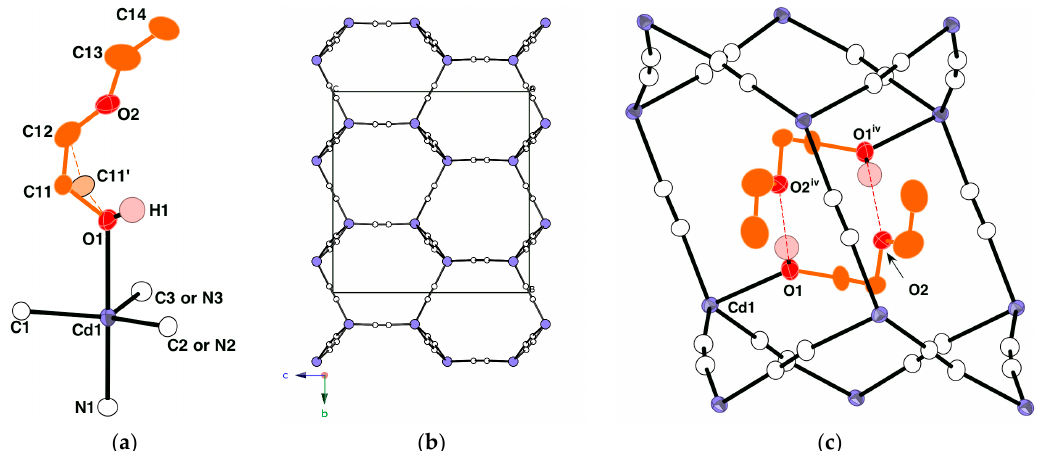
Figure 1. Crystal structure of I . H atoms except OH hydrogens are omitted for clarity: ( a ) Asymmetric unit. Displacement ellipsoids are drawn at the 30% probability level. Because arrangements of cyanides (Cd–NC–Cd or Cd–CN–Cd) are disordered, the atoms of cyanide are labeled less clearly; ( b ) The Cd(CN) 2 network structure view along the a axis; ( c ) Hydrogen bonds between neighboring Etcel ligands in cavities of distorted-tridymite-like cadmium cyanide network of I . Displacement ellipsoids are drawn at the 30% probability level. The disorder part is omitted for clarity. (Symmetry codes: iv = − x + 1, y , − z + 3/2).